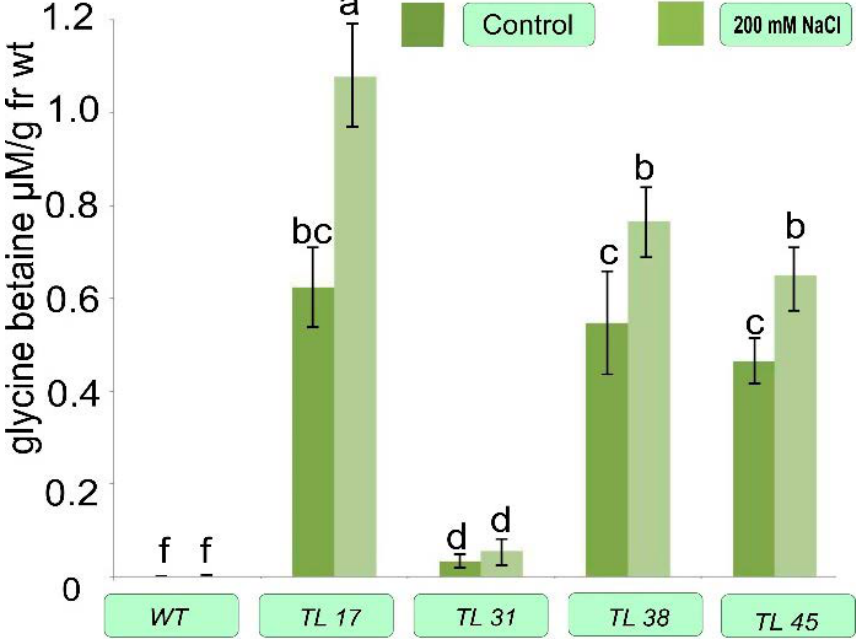
Figure 6. Glycine betaine content in transgenic plant lines. Control—medium Tc without adding